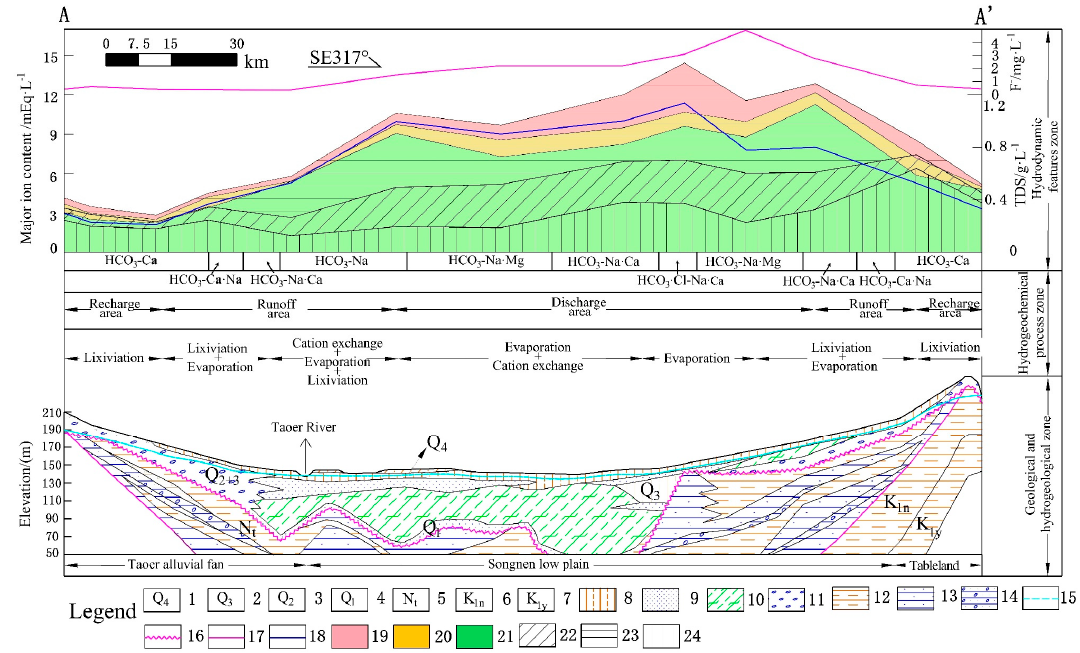
Figure 4. Zoning model for the hydrogeochemical evolution of the study area. The color of stratum: Blue for aquifer, green for aquitard and yellow for aquiclude. Legend: (1) Holocene, (2) upper Pleistocene, (3) middle Pleistocene lower Cretaceous Nenjiang Formation, (4) lower Pleistocene, (5) Neogene system Taikang Formation, (6) lower Cretaceous Nenjiang Formation, (7) lower Cretaceous Yaojia Formation, (8) loess loam, (9) fine sand, (10) silty loam, (11) sandy gravel, (12) mudstone, (13) sandstone, (14) glutenite, (15) unconfined water level, (16) angular unconformity interface, (17) F − , (18) TDS, (19) HCO 3 − , (20) SO 4 2 − , (21) Cl − , (22) Mg 2 + , (23) Na + , (24) Ca 2 + .